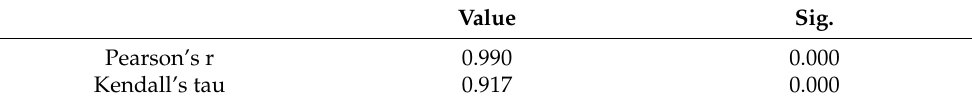
Table 11. Results of